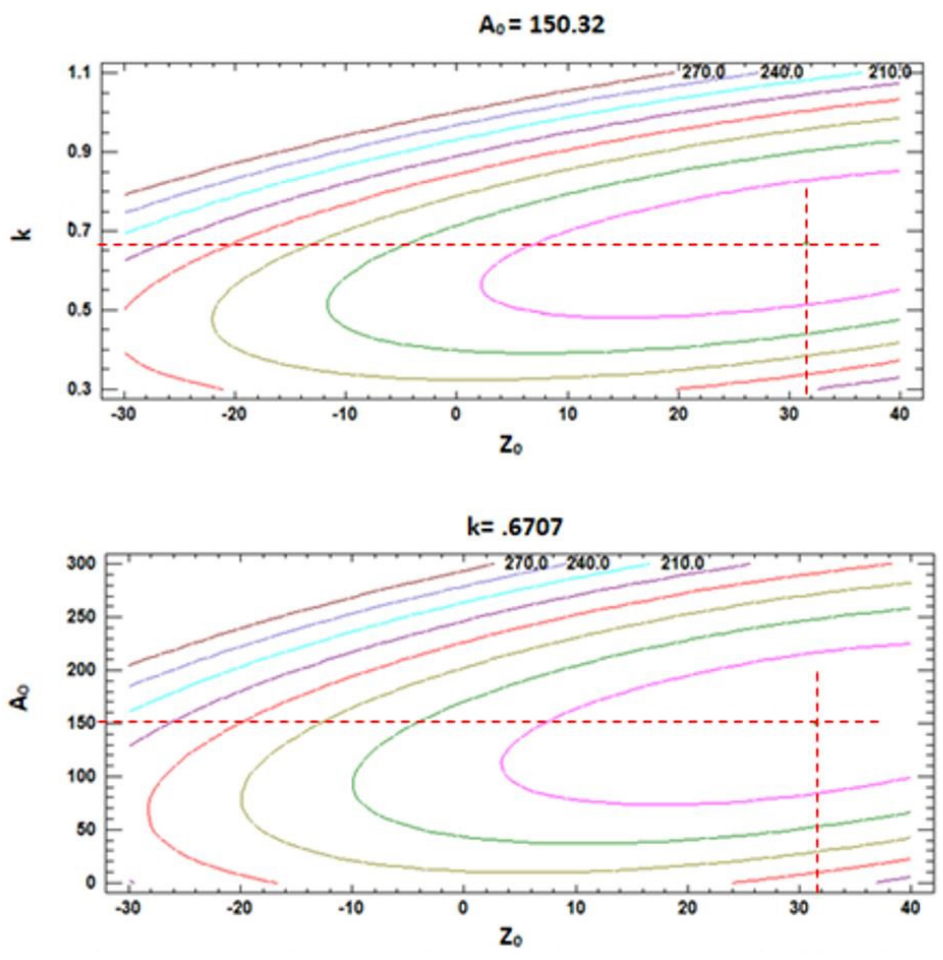
Figure 5. Total cost contour